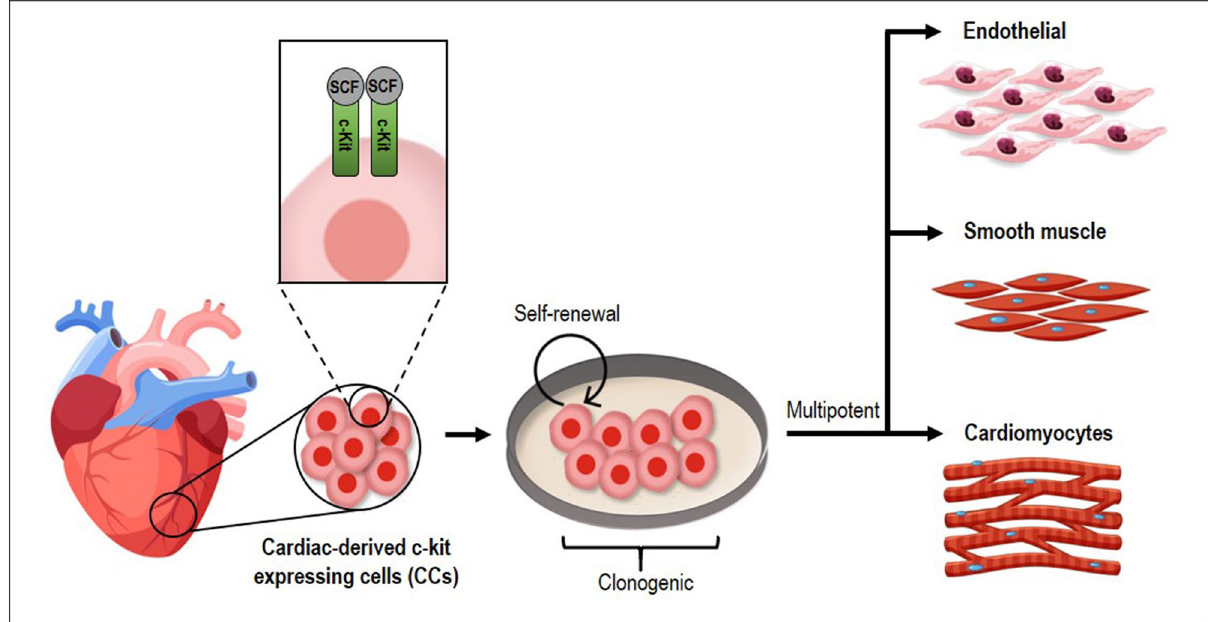
Figure 6. Cardiac-derived c-kit expressing cells (CCs) are self-renewal, clonogenic, and multipotent give rise to cardiomyocytes, smooth muscle, and endothelial cells. c-Kit is a type III receptor tyrosine kinase (RTK) transmembrane receptor involved in multiple intracellular signalling and considered a ligand for stem cell factor